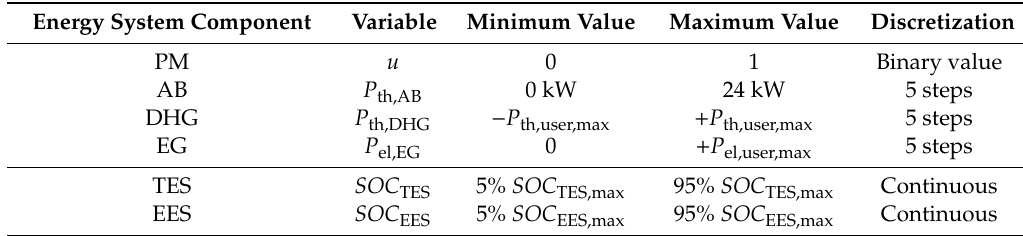
Table 4. Control variables and